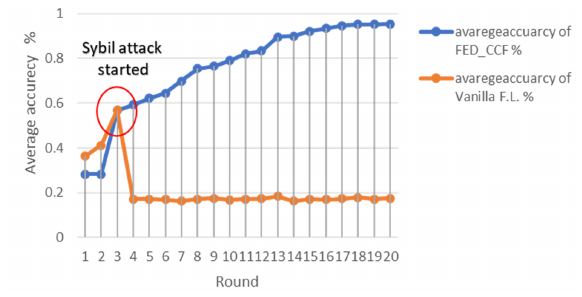
Fig. 5. The classification accuracy of experiment 7 for the FED_CCF and Vanilla